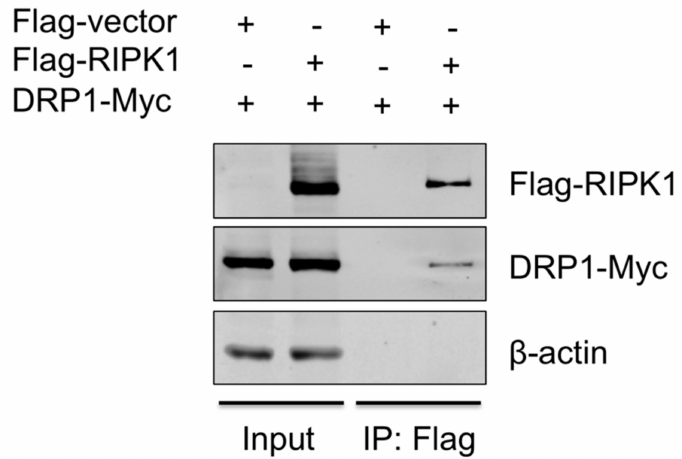
Figure 5. RIPK1 interacts with DRP1. HEK293T cells were co-transfected with the Flag-vector or Flag-RIPK1 construct along with the DRP1-Myc construct for 24 h. Cell lysates were subjected to co-IP with Flag antibody, and the expression of Flag-RIPK1 and DRP1-Myc in input and IP samples was analyzed by Western blotting. Results are representative of three independent